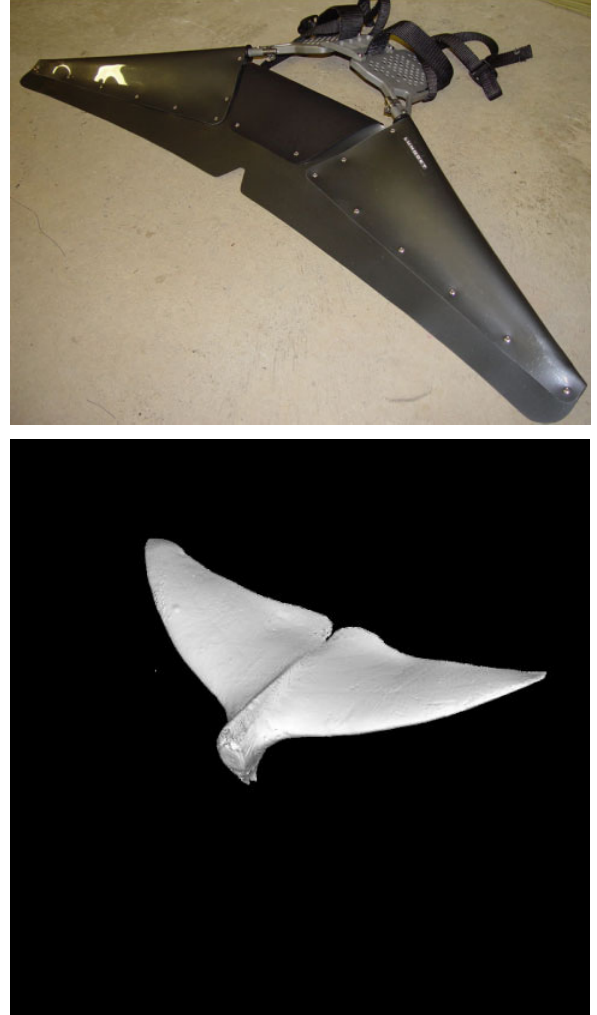
Figure 5 Biomimetic monoflipper for dolphin-like swimming (top) and three-dimensional reconstruction of dolphin flukes from CT scans (bottom). Photograph of monoflipper courtesy of T. Ciamillo.